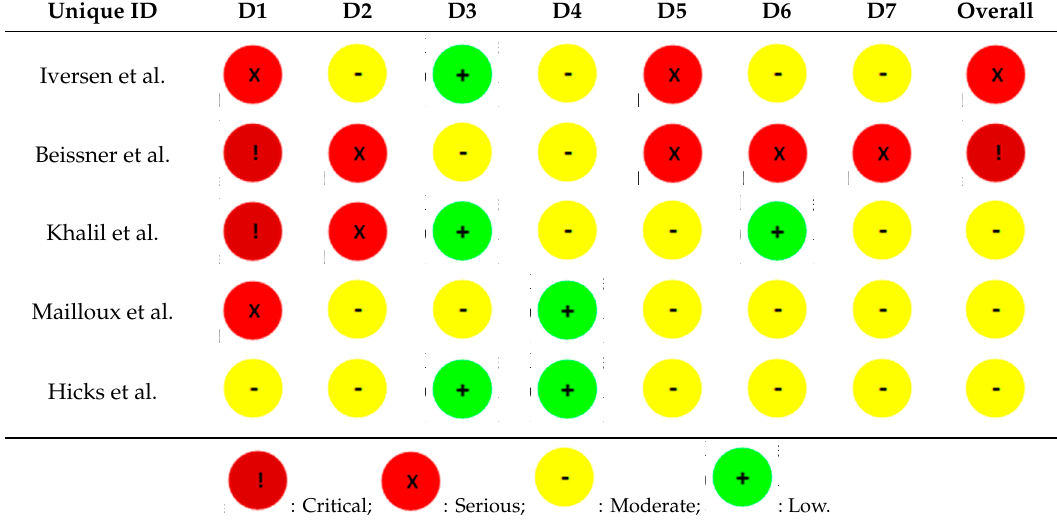
Table 1. Cochrane tool for assessing risk of bias in randomized trials (RoB 2 tool).